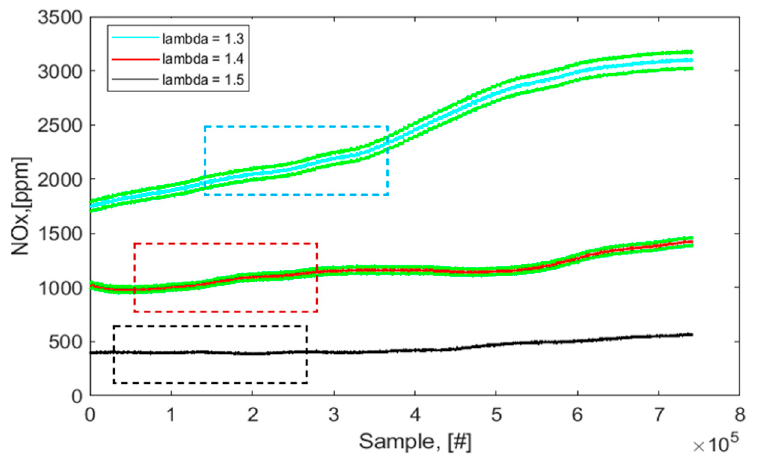
Figure 7. NOx trend of 103 consecutive experimentally acquired events on the optical access engine. The dashed boxes indicate the region of interest in which the NOx prediction was performed. The measurement error of each recorded point is represented by the green curves. The higher the recorded value, the higher the error committed. At λ = 1.5, the curve hinders the measurement error.